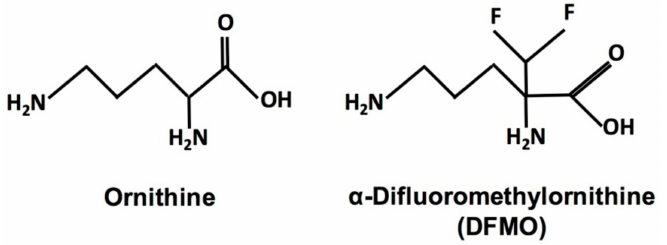
Figure 1. Structures of ornithine and the fluorinated ornithine analog α -difluoromethylornithine